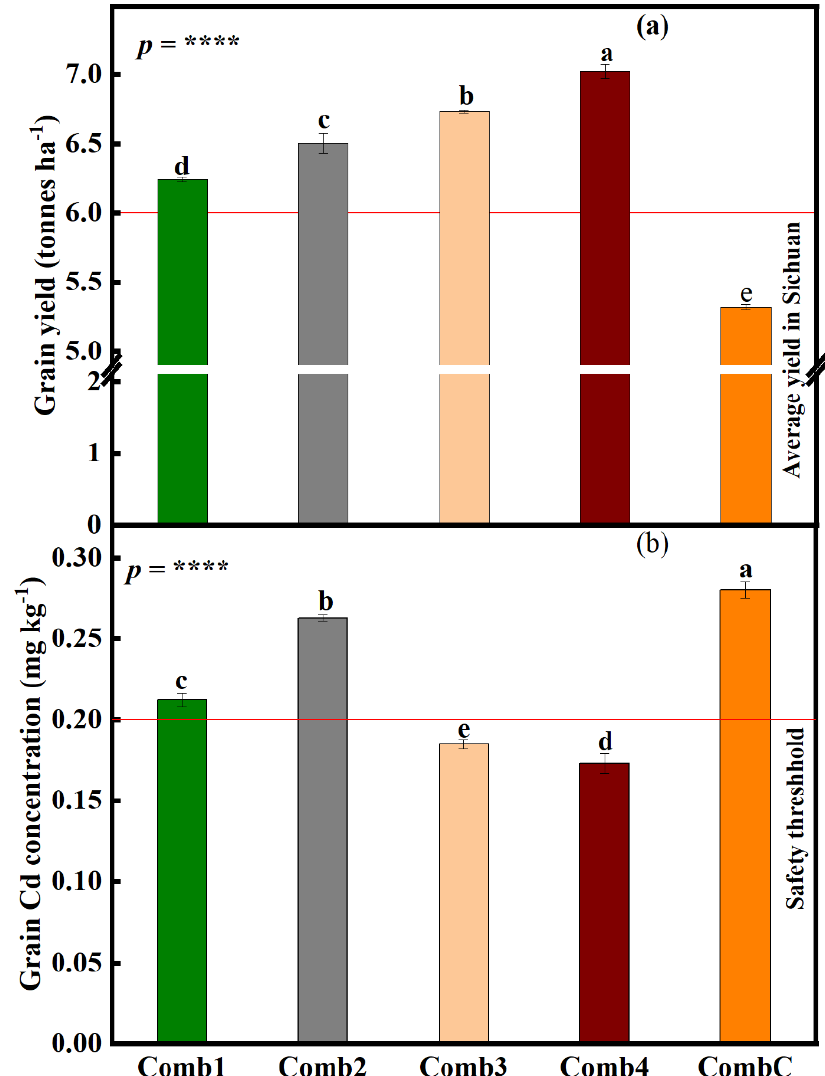
Figure 5. Effects of different combination treatments on ( a ) grain yield and ( b ) grain Cd concentrations under the large-scale field experiment. Data (means ± SE, n = 5) followed by different subscripts denotes significant differences between treatments at p < 0.05 according to Tukey’s HSD. p -values of one-way ANOVA, are indicated ****, p < 0.0001. Combinations treatments: humic acid + soil dressing silicon fertilization + deep-plowing (15–30 cm) (Comb1); humic acid + soil silicon dressing fertilization + shallow plowing (5–10 cm deep) (Comb2); humic acid + soil dressing silicon fertilization + deep plowing (15–30 cm) (Comb3); humic acid + soil dressing silicate fertilization + foliar dressing silicon fertilization + shallow plowing (5–10 cm) (Comb4), and; normal plowing with no additional fertilization (CombC).